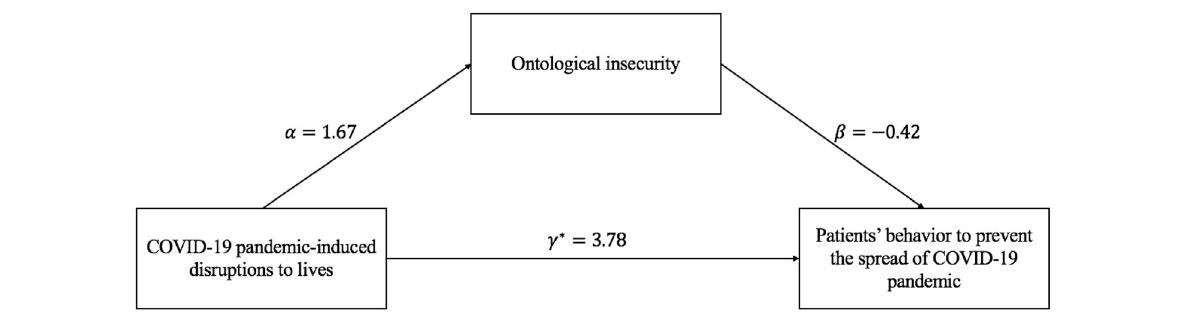
FIGURE 2 | Pathway between COVID-19 pandemic-induced disruptions, ontological insecurity, and patients’